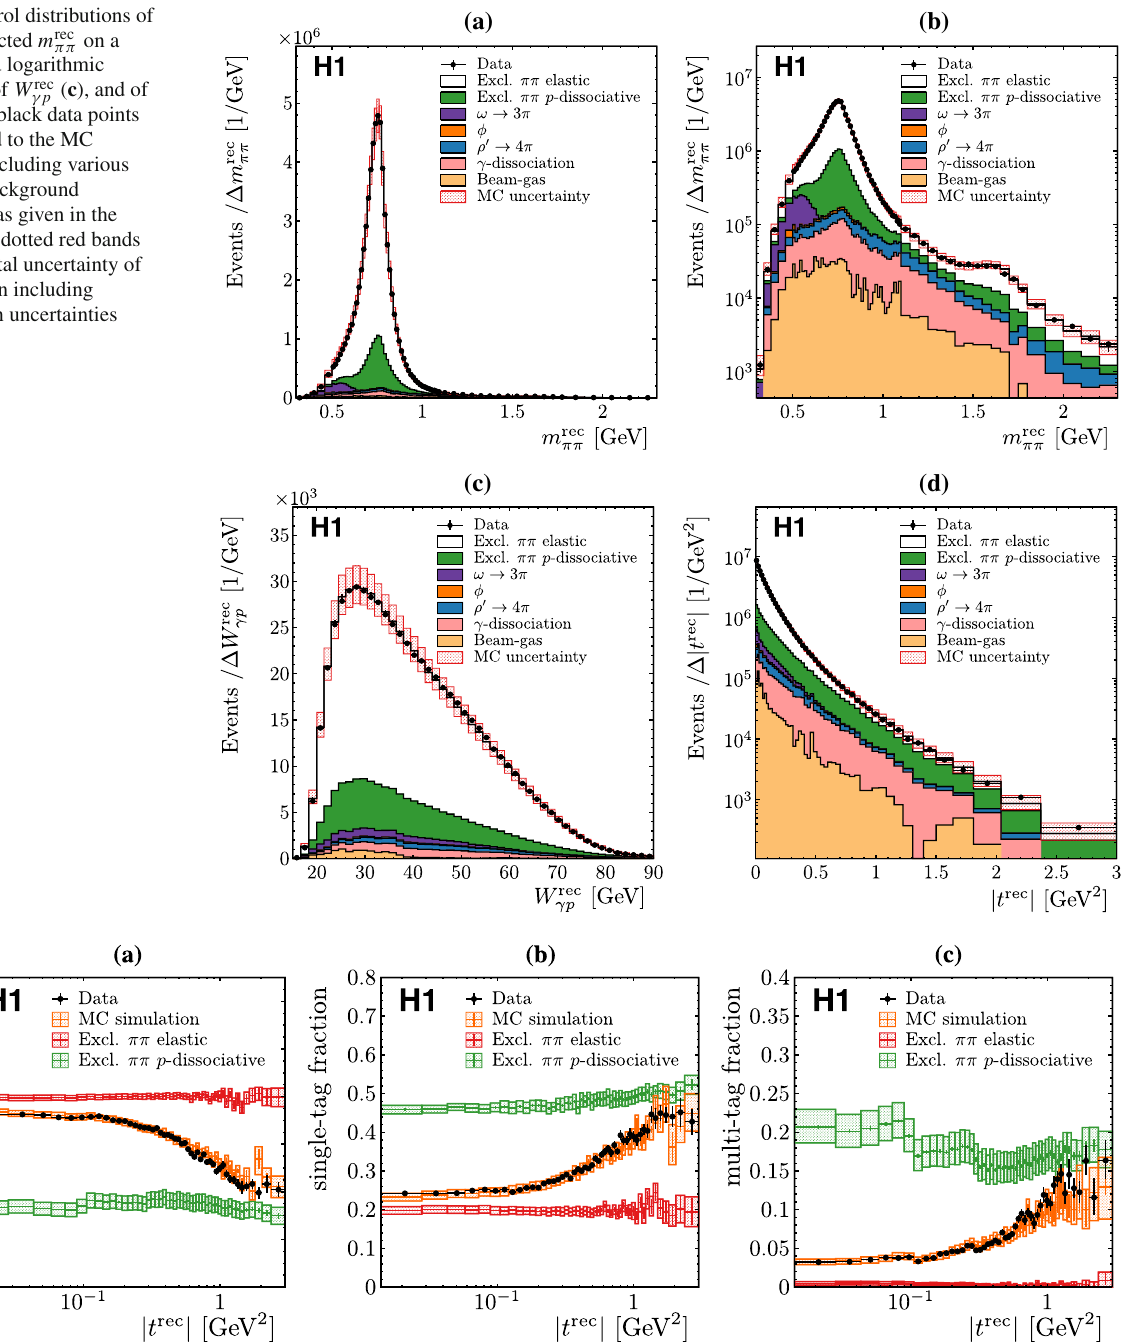
Fig. 4 Zero- ( a ), single- ( b ), and multi-tag fraction ( c ) using tagging information from the FMD, the FTS, and the PLUG as a function of | t rec | . The fraction measured in data is given by the black points. The orange bands show the corresponding fraction predicted by the MC